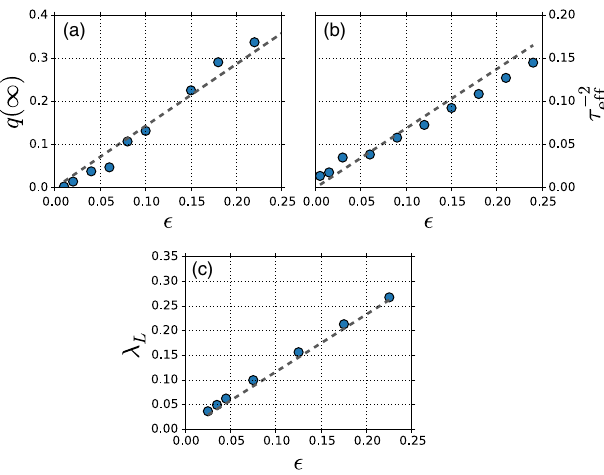
FIG. 9. Critical behavior of a single inhibitory population with quadratic ( ν ¼ 2 ) transfer function . Normalized variance (a), network relaxation time (b), and LE (c) for small ϵ ≡ g 2 =g 2 gain above the critical point. Circles show the average over 20 simulations (Gaussian connectivity in the balance regime, N ¼ 6000 , K ¼ 1200 , h 0 ¼ 1 ), and dashed lines show theoretical predictions (see Appendix